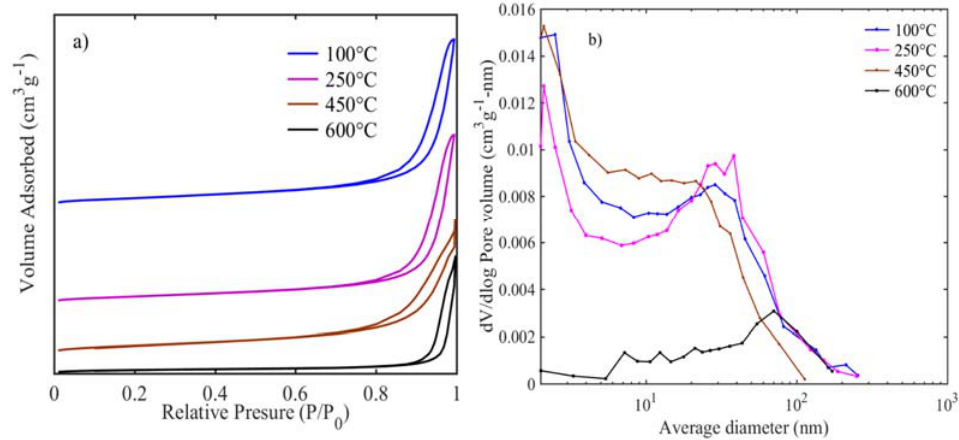
Figure 3. N 2 adsorption-desorption isotherm ( a ) and corresponding pore size distributions ( b ) of Ni Fe oxide at the different temperatures.